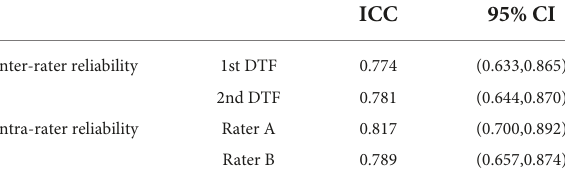
FIGURE2 ROC curves of risk stratification tools in predicting respiratory failure in patients with community-acquired pneumonia. ROC, receiver operating characteristic; DTF, diaphragm thickening fraction; DE, diaphragm excursion; PSI, pneumonia severity index; IDSA/ATS, Diseases Society of America/American Thoracic Society.